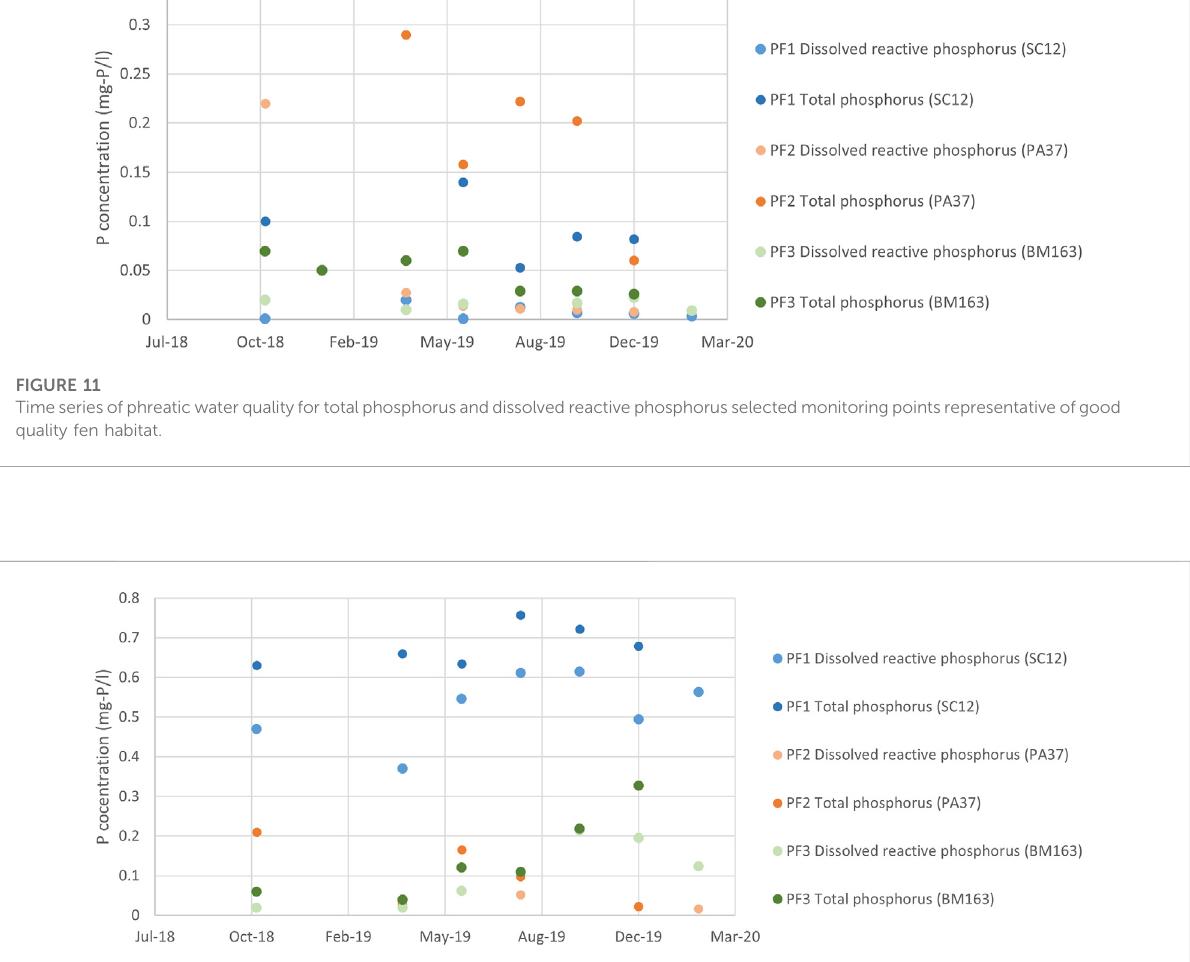
TABLE 3 Nutrient concentration envelopes for habitats in good ecological condition within Irish calcareous fens. Fossitt habitat